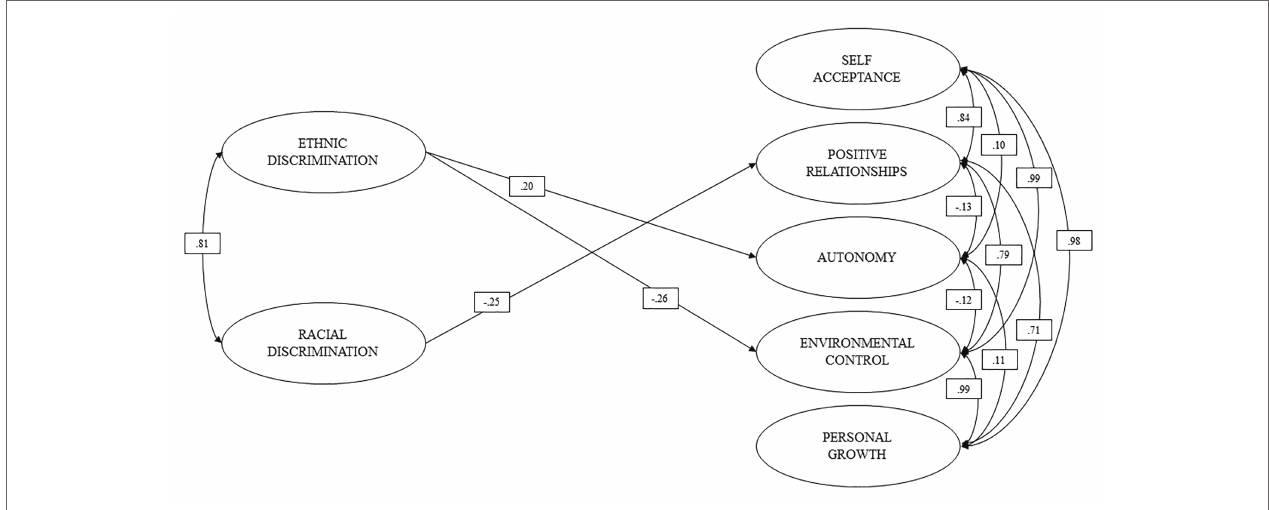
FIGURE 2 | Relationship between discrimination and